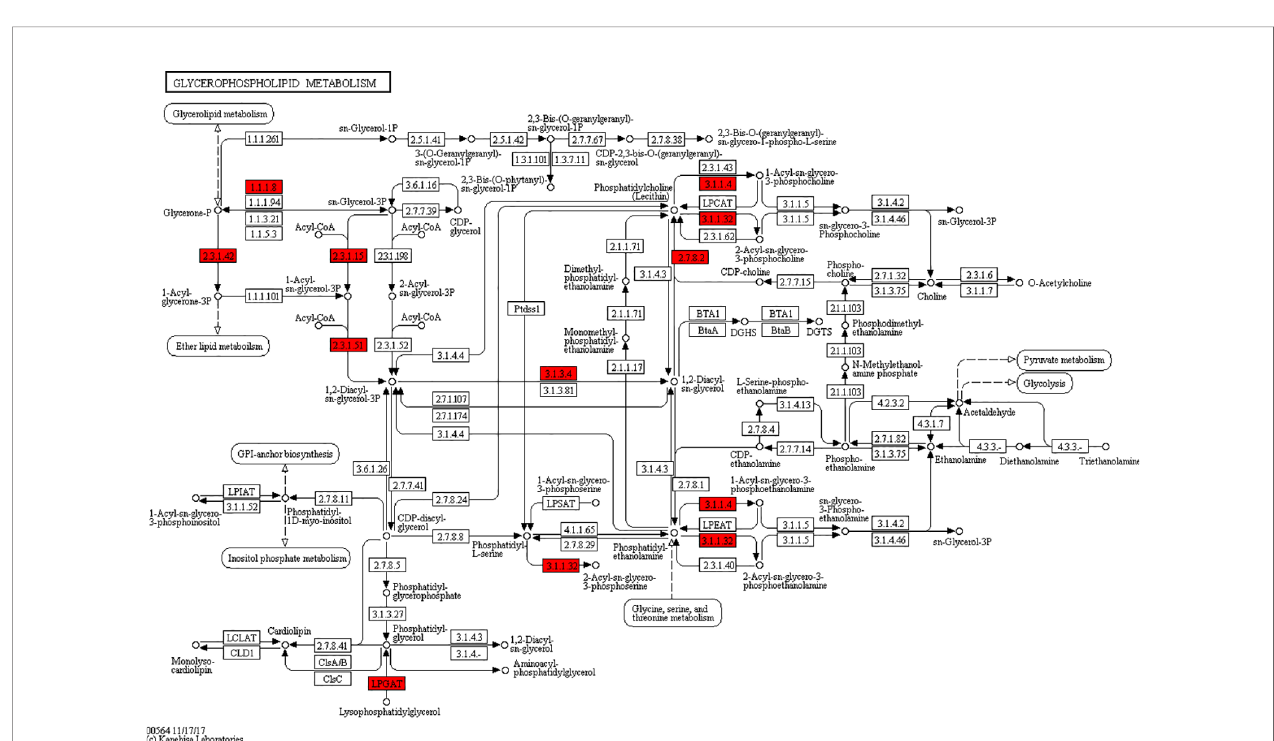
FIGURE 9 | Network of glycerophospholipid metabolic